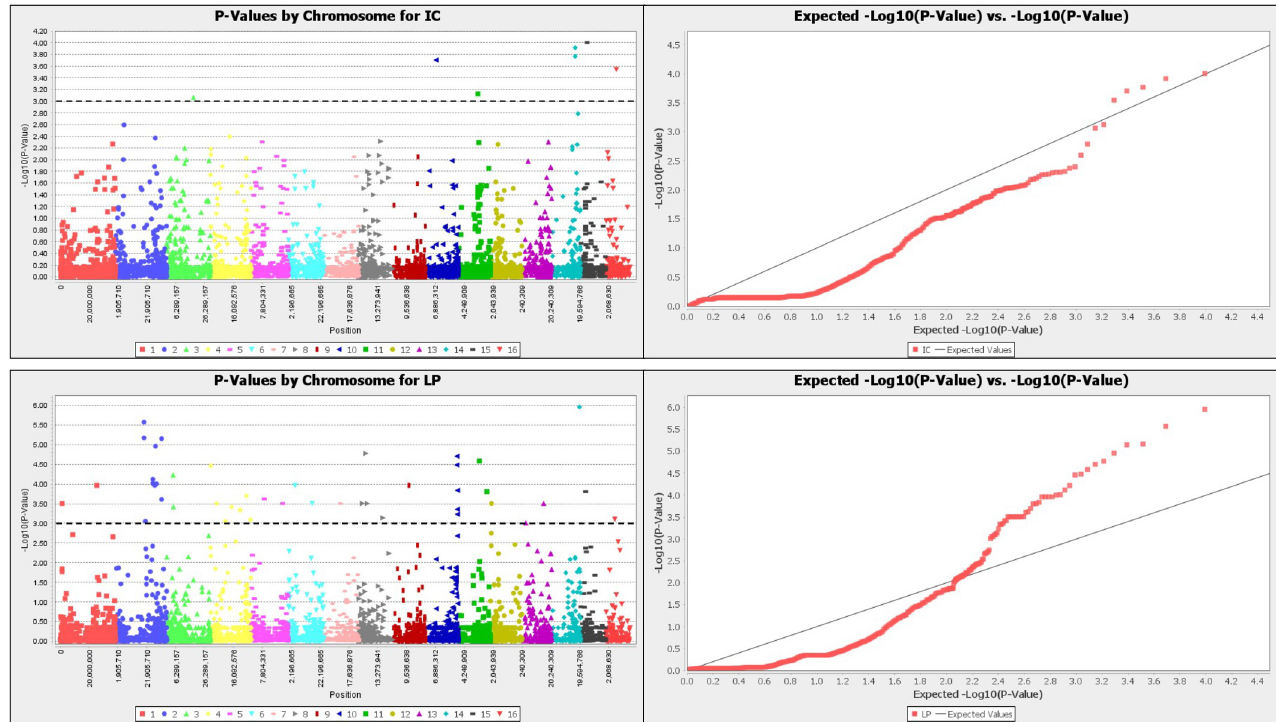
Fig 6. Manhattan plot and QQ plot for inflorescence color (IC), leaf pigmentation (LP), petiole pigmentation (PP) and stem pigmentation (SP) of 118 A . tricolor